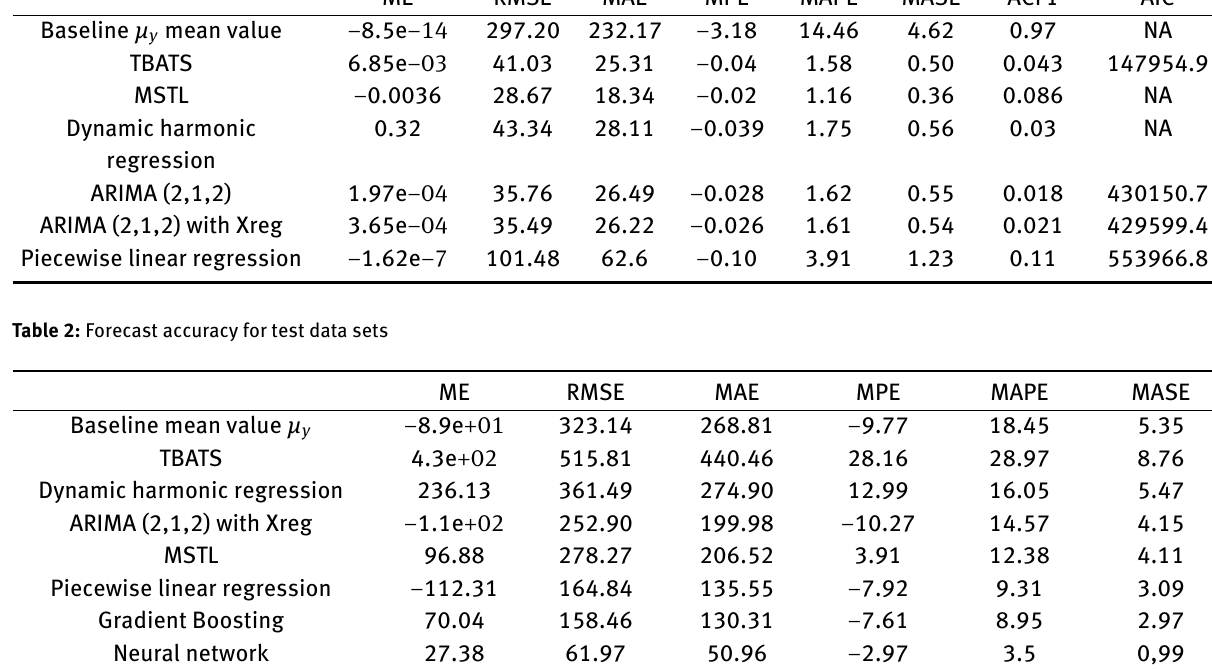
The estimated temperature breakpoint by segmenta- tion algorithm [43] is 287.74 degrees of Kelvin. The piece- wise model explains 74.42% of electricity consumption variation. The Temperature coefficients of the piecewise linear model are given in (21), the full model is given in Appendix 2.